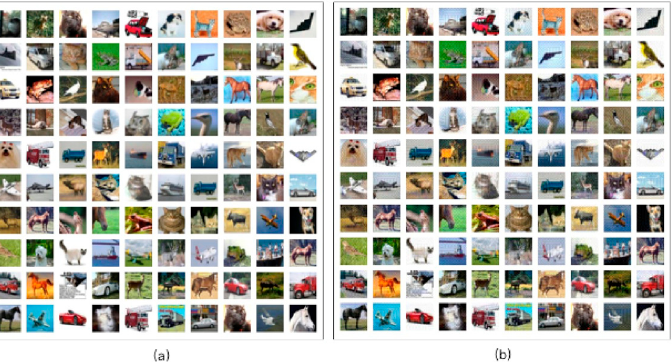
Figure 4. Visualization of AE generated by DDSG-GAN for attacking the ResNet32 on CIFAR10. ( a ) original samples randomly selected from the training set; ( b ) AE generated by DDSG-GAN for the corresponding target model.